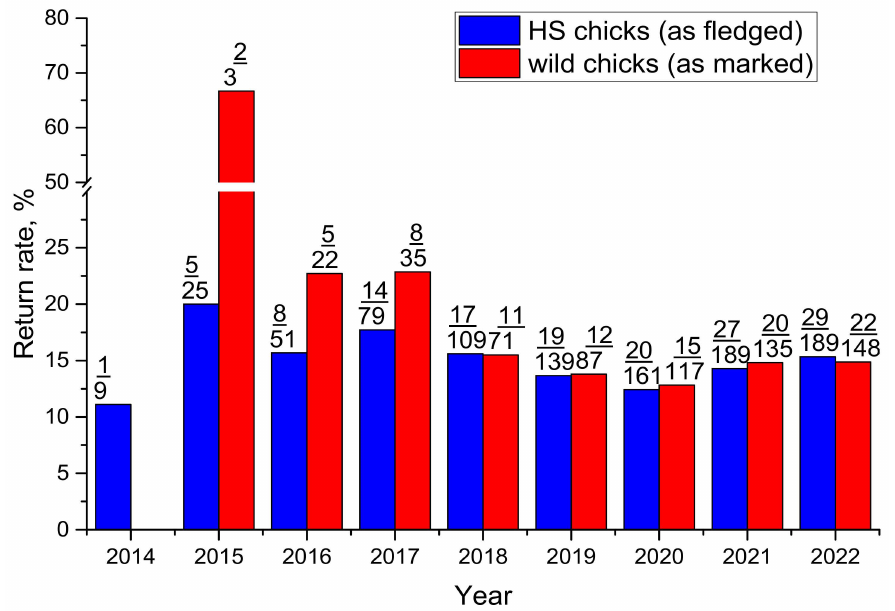
Figure 6. Return rates of HS and wild chicks (the upper number indicates the cumulative number of chicks returned by each year, while the lower value shows the number of second-year birds that could potentially return).